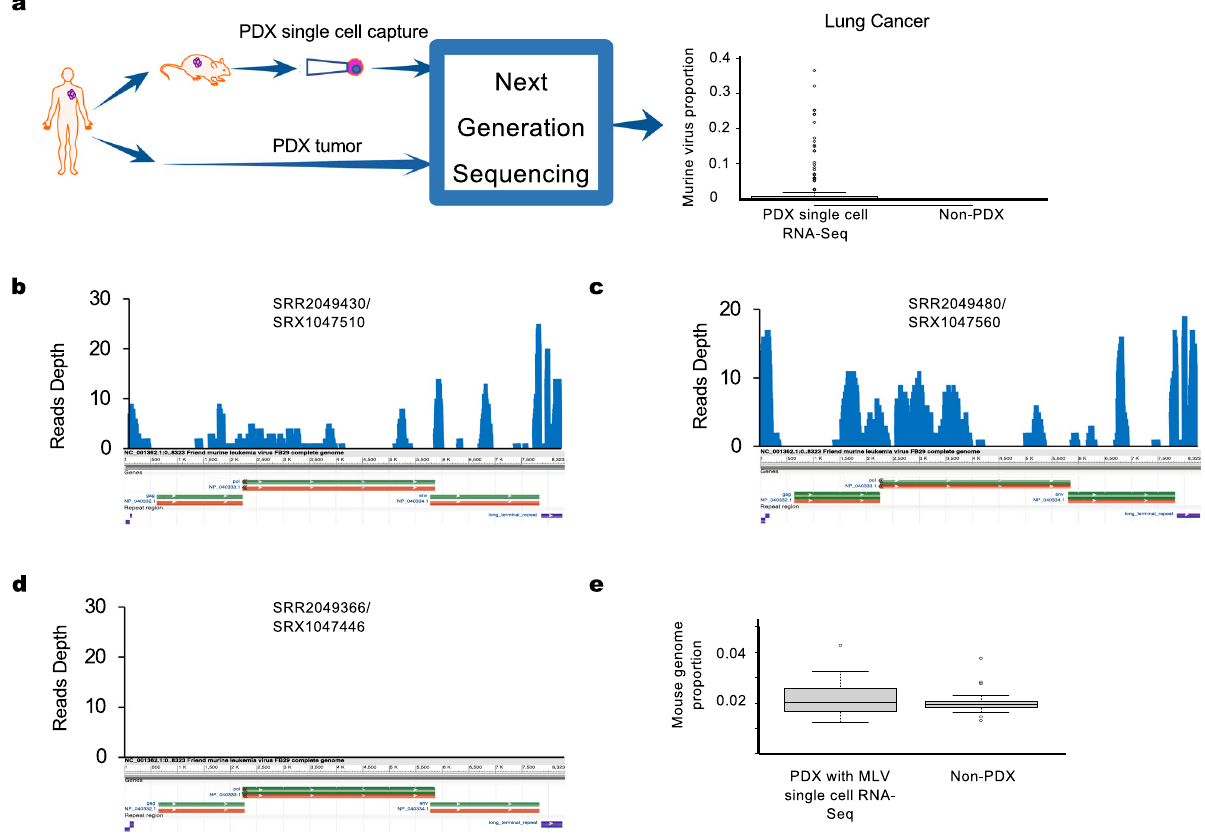
Fig. 3 Single-cell sequencing support the presence of murine viruses inside PDX tumor cells. a Relative proportions of murine viruses in the virome of lung cancer PDX cells are signi fi cantly higher than in the cells from the primary lung cancer samples as measured by single-cell RNA-Seq (PDX: n = 1147; non-PDX: n = 152). b , c Viral reads from single-cell sequencing of PDX-derived tumor cells cover the entire genomic region of MLV. d No single-cell sequencing reads from non-PDX control samples were observed or mapped to the viral genome. e The single-cell sequencing reads that can be mapped to the mouse reference genome are very low in both PDX-derived tumor cells and non-PDX control cells (PDX: n = 9; non-PDX: n = 152). For box plots in ( a ) and ( e ), Box limits: 25th and 75th percentiles; center line: median; whiskers: 1.5x interquantile range from box limits; dots: outliers. Source data for a and e are provided in Source Data